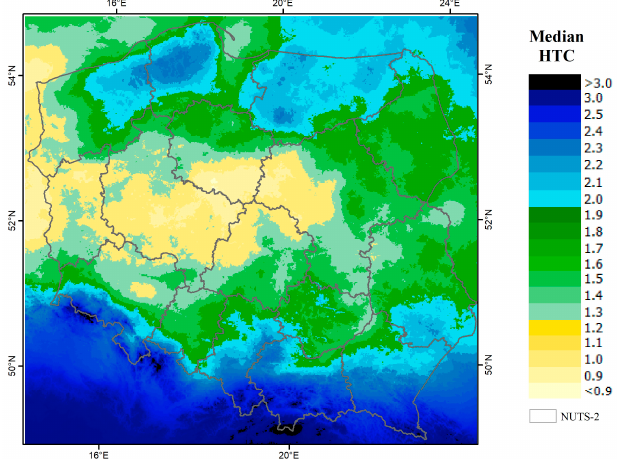
Figure 6. HTC average for Poland.